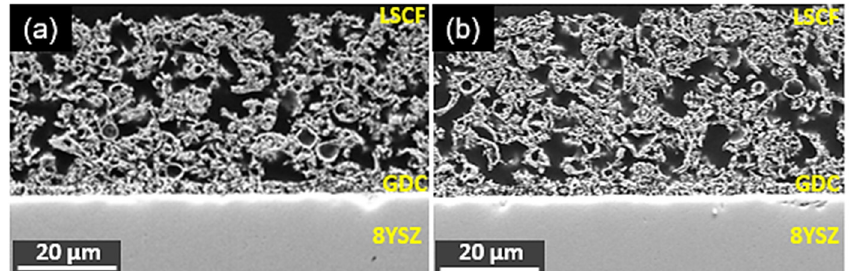
Figure 4. SEM images of oxygen electrode sides, for 3Mo-3Au-Ni-GDC/8YSZ/GDC/LSCF single cells ( a ) before and ( b ) after 1700 h steam electrolysis operation at 900 °C with 63 vol.% H 2 O + 30 % vol.% N 2 + 7 vol.% H 2 feed gas mixture and − 0.3 A ‧ cm − 2 current load.